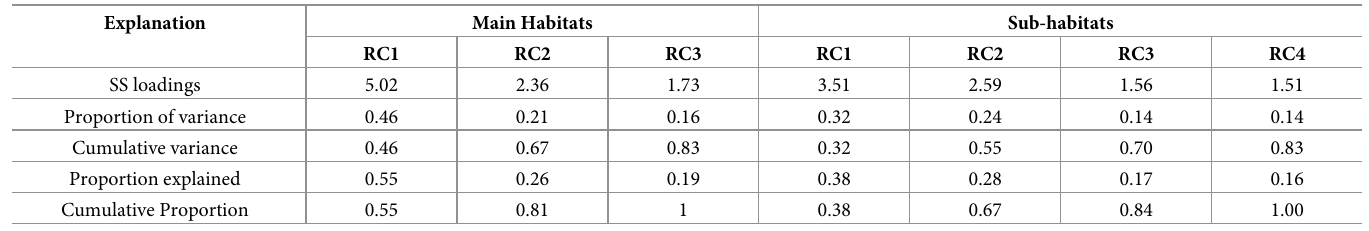
Table 4. Explanatory power of each factor.